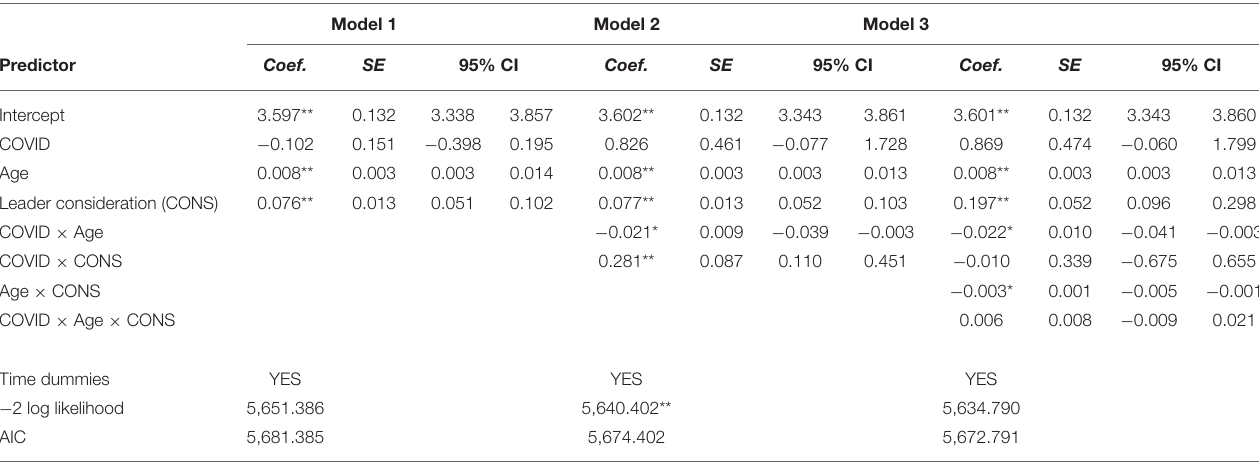
TABLE 2 | Multilevel model predicting daily